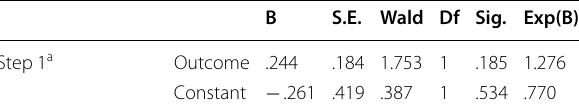
Table H: Variables in the equation for outcome orientation culture